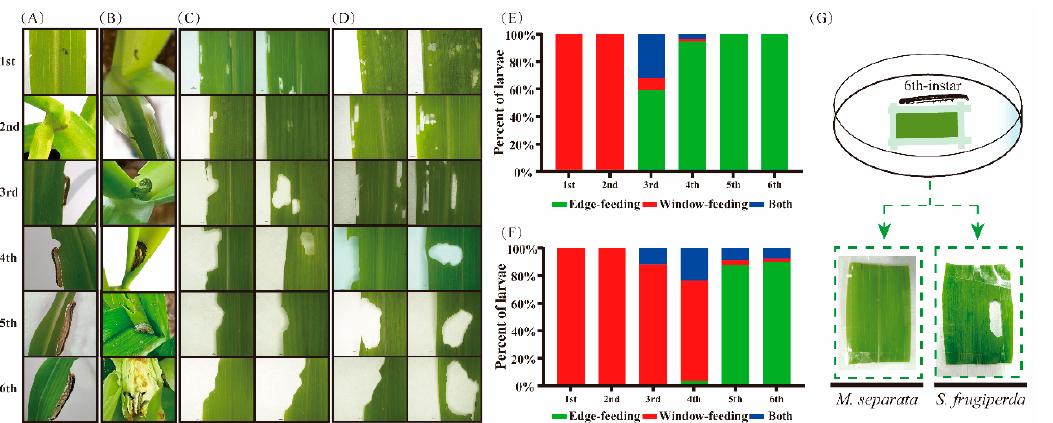
Figure 1. Feeding behaviors of two armyworm species. Feeding patterns of 1st–6th instar oriental armyworm ( A ) and fall armyworm ( B ) in maize in the field. Feeding patterns of 1st–6th instar ori- ental armyworm on maize leaves, with two leaves representing window-feeding for 1st–2nd instar, edge- and window-feeding for 3rd–4th instar, and edge-feeding for 5th–6th instar larvae ( C ). Feeding patterns of 1st–6th instar fall armyworm on maize leaves, with two leaves representing window-feeding for 1st–2nd instar and edge- and window-feeding for 3rd–6th instar larvae ( D ). Percentages of different feeding patterns of 1st–6th instar oriental armyworm ( E ) and fall armyworm ( F ) on maize leaves. ( G ) Window-feeding abilities of two armyworm species with larvae reared on maize leaves sellotaped on the petri dish.